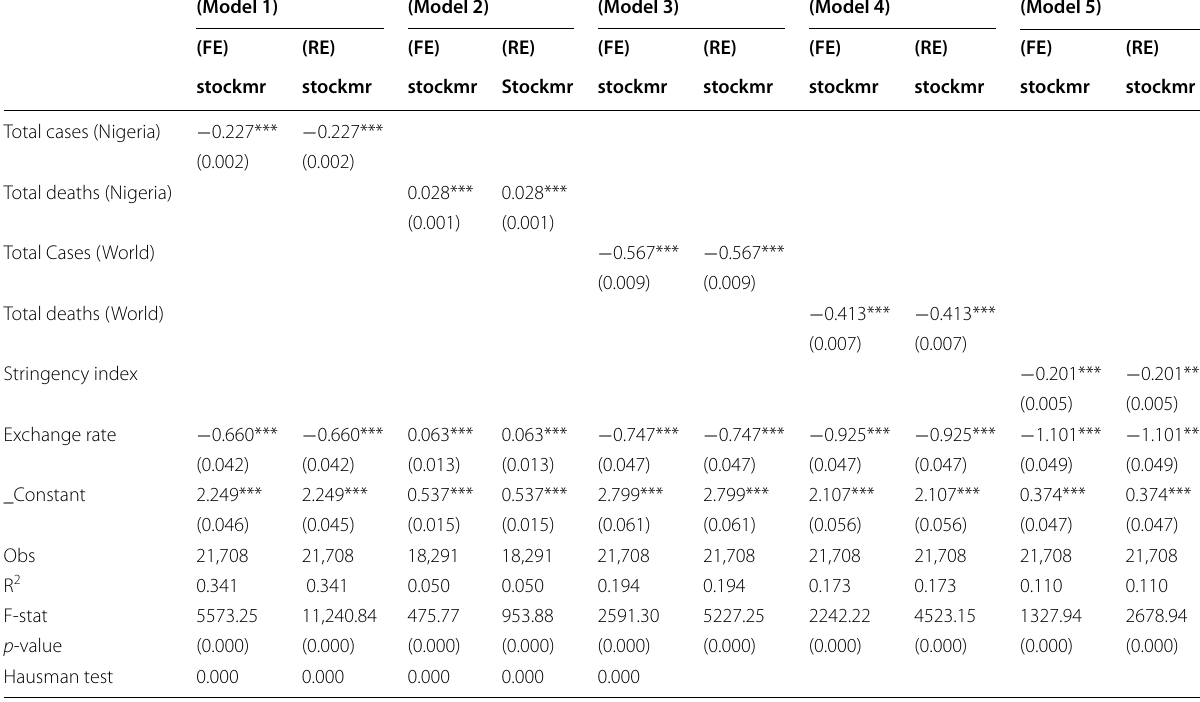
Table 9 Fixed effects and random effects